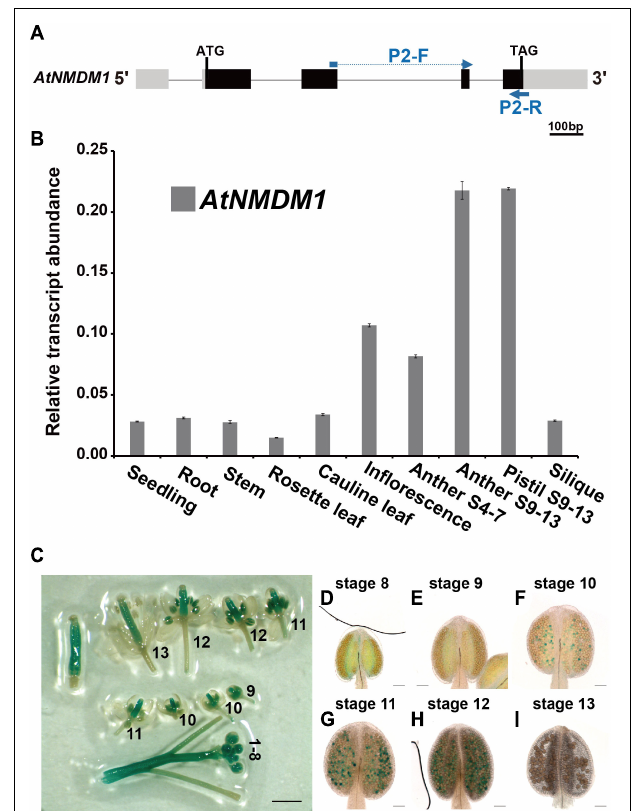
FIGURE 2 | Expression profile analysis of AtNMDM1 in various tissues. (A) The transcript abundance of AtNMDM1 among different Arabidopsis tissues was determined by real-time PCR and normalized against ACTIN-2 . The primers, P2-F and P2-R of cDNA fragments in the AtNMDM1 are indicated by blue arrows. (B) The transcription levels of AtNMDM1 were highly expressed in the anther and pistil at anther stages 9–13 (anther S9–13 and pistil S9–13), compared with the other tissues, including the seedlings, roots, stems, rosette leaves, cauline leaves, inflorescence, anthers stages 4–7 (anther S4–7), and siliques. The bars represent mean ± standard error (SE) of three biological replicates. (C–I) AtNMDM1 promoter triggered GUS expression in flowers and anthers at different developmental stages. (C) The number represents the developmental stage of the flower. (D–I) Anthers are shown at anther stages 8–13. The blue points in the anthers represent the GUS signals in the pollen. bar = 1 mm; (D–I) , bar = 50 µ